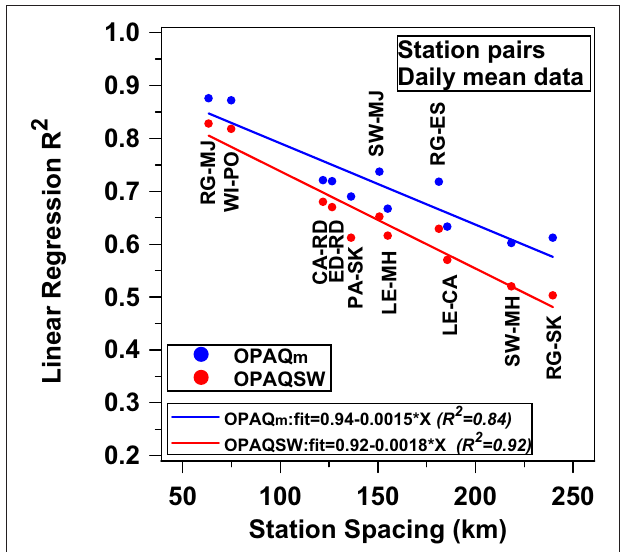
FIGURE 3 | Decrease of correlation of daily opaque cloud with increasing station spacing.